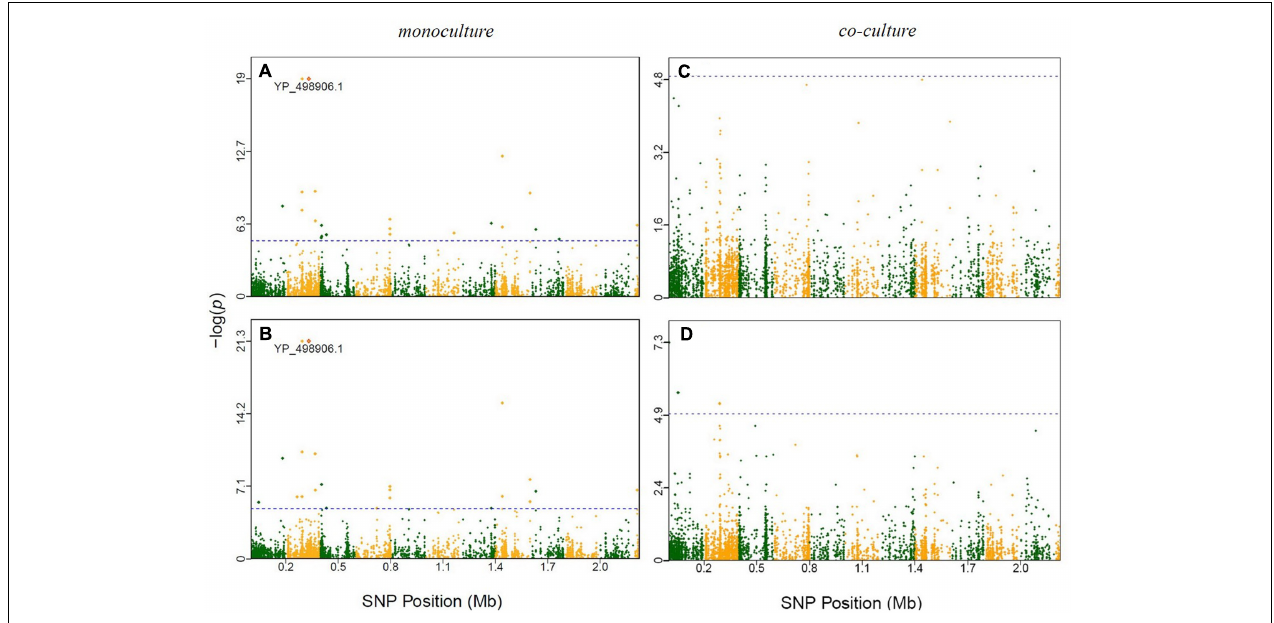
FIGURE 3 | Manhattan plots of GWAS results for S. aureus in monoculture and co-culture. The x -axis showed SNP positions (Mb) and the y -axis was the –log( P -value) resulting from the association test. Each dot in the plot represented an SNP, and a reference line was used on the y -axis to reflect genome-wide significance. Significant SNP identified in previous evolutionary studies were highlighted. (A) Time point 4; (B) time point 5; (C) time point 4; (D) time point